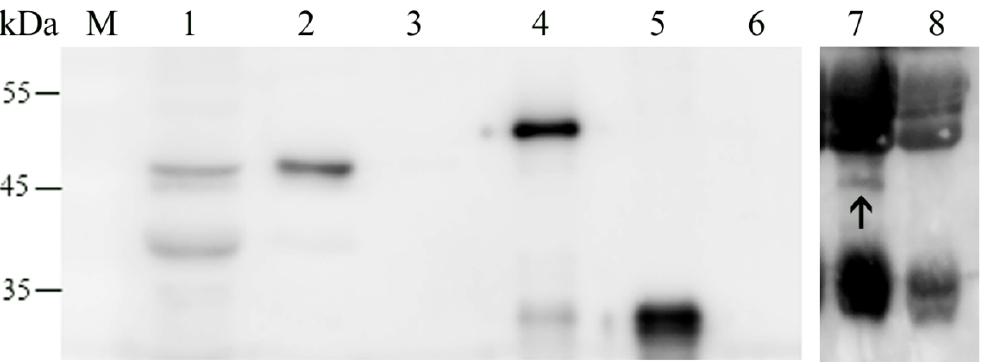
Figure 5. Localization of MbovNase in M. bovis cells detected with western blot analysis. The different fractions of M. bovis cells, culture supernatant and the purified rMbovNase or rMbovNase Δ 181–342 were subjected to SDS-PAGE and western blot analysis with mouse antiserum to rMbovNase. MbovNase is not only present in total M. bovis cell protein (Lane 1) and membrane fraction (Lane 2), but also in culture supernatant as a secretory protein (shown by the arrow in lane 7). However, it was not in the cytoplasmic fraction (Lane 3). The rMbovNase (Lane 4) is 4 kDa larger than the nature MbovNase due to 6 ×His tag, while rMbovNase Δ 181–342 (Lane 5) is about 30 kDa, 18 kDa smaller due to the deletion of TNASE_3 domain. The pure bovine serum albumin (Lane 6) does not produce any band, while the media with many nonspecific proteins from horse serum and yeast extract display nonspecific bands in lane 7 and 8, however there is no target band in lane 8 as shown by the arrow in lane 7. Molecular weight of the reference proteins (kDa) is indicated on the left.